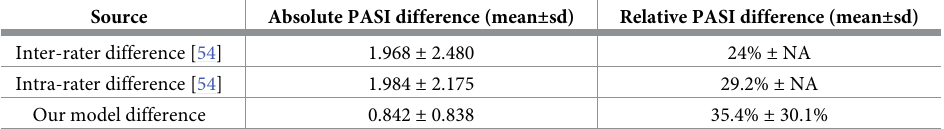
Our model difference The uvb s parameter of the models was estimated taking into account the full PASI trajectory. The mean assessed PASI value was 8.8 and the range was [0.7, 34.8] (the corresponding figures in our dataset are 4.01 and [0, 31.8]), and the best mean absolute PASI difference was (reported for observers 1 and 2) 1.968 with standard deviation of 2.480, while the best mean absolute intra-observer PASI difference (the difference between the PASI assessments for observer 2) was 1.984 with a standard deviation of 2.175. NA—value is not